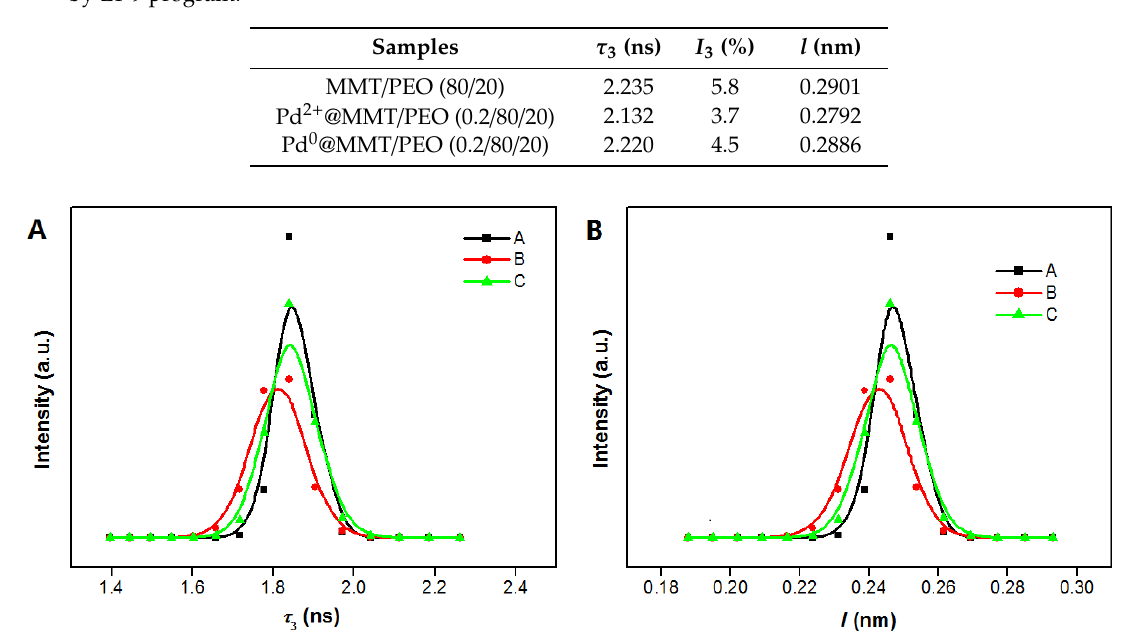
Figure 4. Distribution of the longest lifetime ( τ 3 ) ( A ) and corresponding micro-defect’s size ( l ) ( B ) of the samples analyzed by MELT-4 program. A. MMT/PEO (80/20); B. Pd 2+ @MMT/PEO (0.2/80/20); C. Pd 0 @MMT/PEO